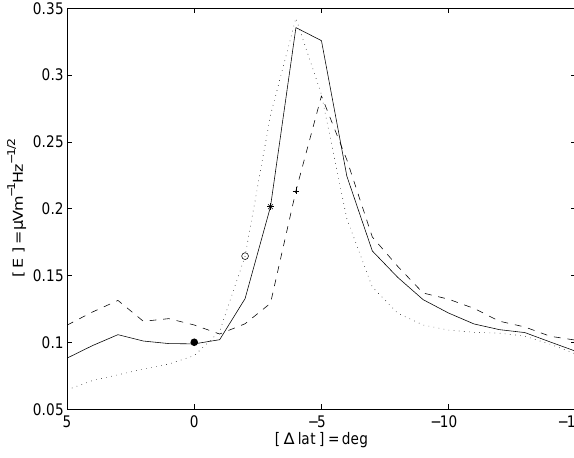
Fig. 3. The latitude scans through the mean luminosity patches from all LORAN transmitters (solid line), transmitters at low ( L < 2.4) geomagnetic latitudes (dashed line), and at high ( L > 2.4) geomagnetic latitudes (dotted line) are referenced to the mean transmitter location (dot). The apparent transmitter locations at ∼ 660km height are located southward when an upward propaga- tion of the radio waves along the geomagnetic field lines is assumed for low latitude transmitters (plus), for all transmitters (star) and for high latitude transmitters (circle). The remaining residual dis- placement between the apparent transmitter locations and the maxi- mum intensities of the corresponding luminosity patches range from ∼ 100km for low latitude transmitters, ∼ 150km for all transmit- ters and up to ∼ 200km for high latitude transmitters. The varying residual displacement suggests that the smaller inclination of the ge- omagnetic field lines at low latitudes helps to trap the radio waves and to keep them in the magnetospheric